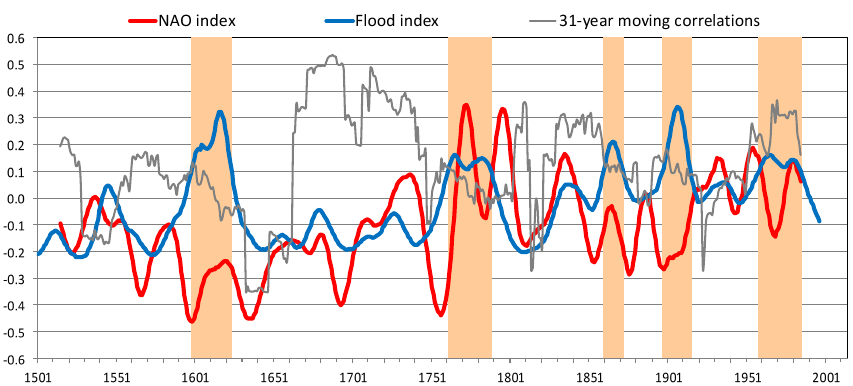
Figure 8. Temporal evolutions of total flood index series and the number of days exceeding a daily precipitation threshold for Barcelona (1854–2012): (a) 20mm, (b) 30mm, (c) 50mm and (d) 100mm. Data have been smoothed by an 11year Gaussian low-pass filter. The 31year moving correlations between floods and the different daily precipitation thresholds are also displayed in each panel. The results of applying a trend analysis in the number of days and the temporal correlations between them and floods for all the periods are also shown.